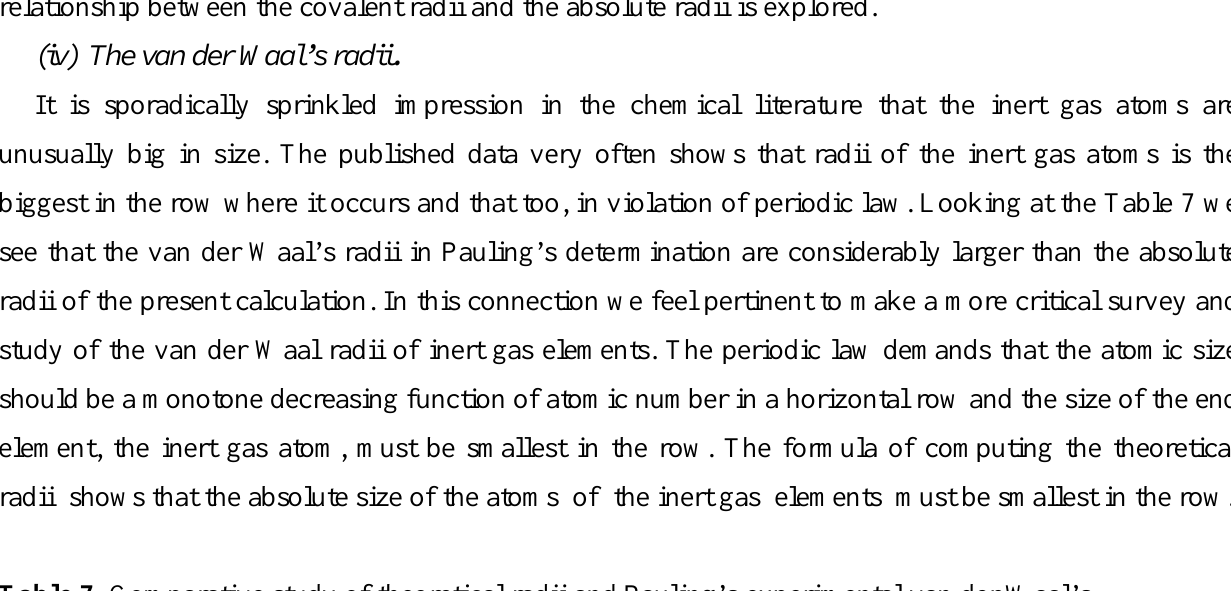
Table 7. Comparative study of theoretical radii and Pauling’s experimental van der Waal’s radii of